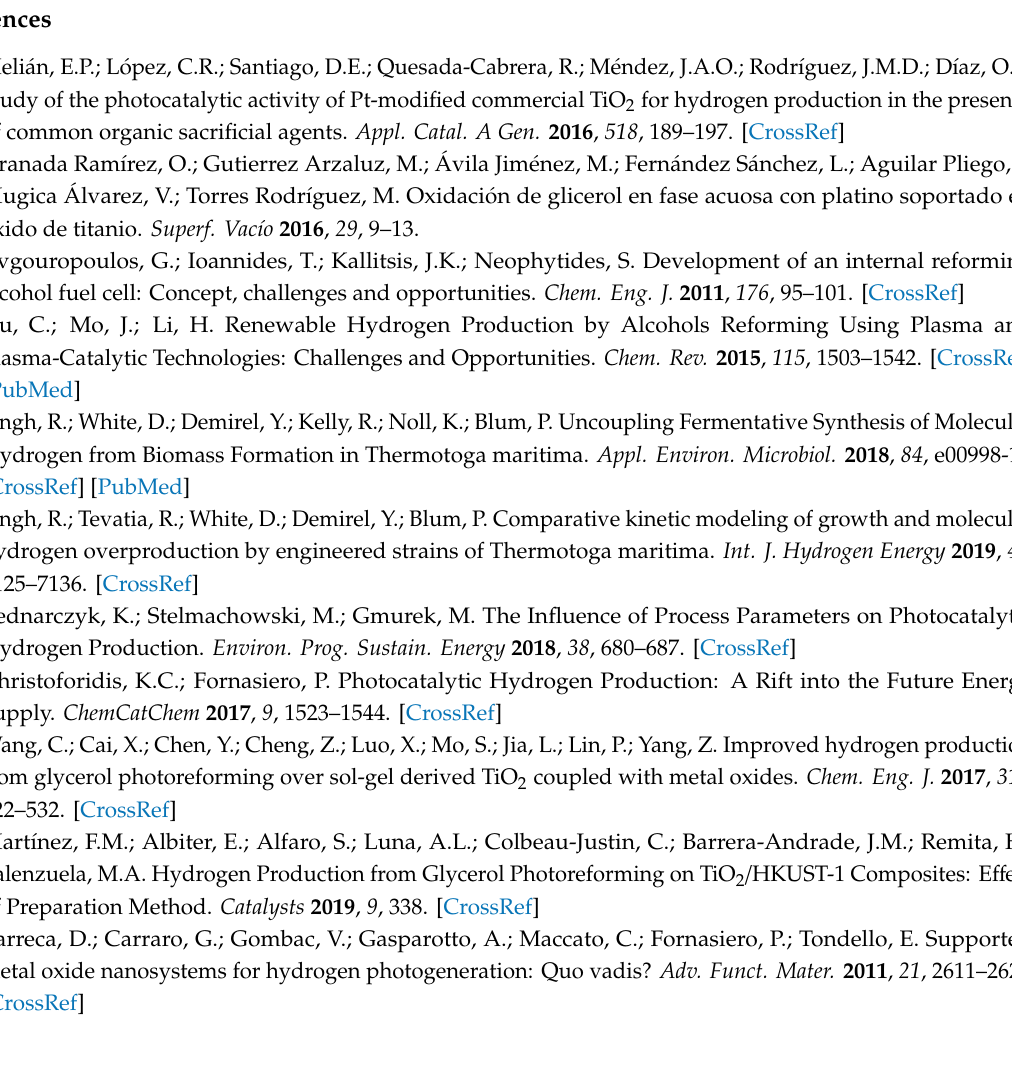
Figure S1. Hydrogen calibration plot used in this work. Figure S2. A typical chromatogram obtained in the hydrogen quantification process through GC. Figure S3. X-ray di ff ractograms of Evonik P25, Ni-0.5-DP. Ni-0.5-IMP, Ni-0.5-DP-Red and Ni-0.5-IMP-Red. Figure S4. Band-gap energy (Eg) calculation for the Ni-0.5-IMP-Red catalysts. Figure S5. Particle size distribution of each catalyst. Figure S6. XPS profiles for the Ni 2p3 / 2 component of each